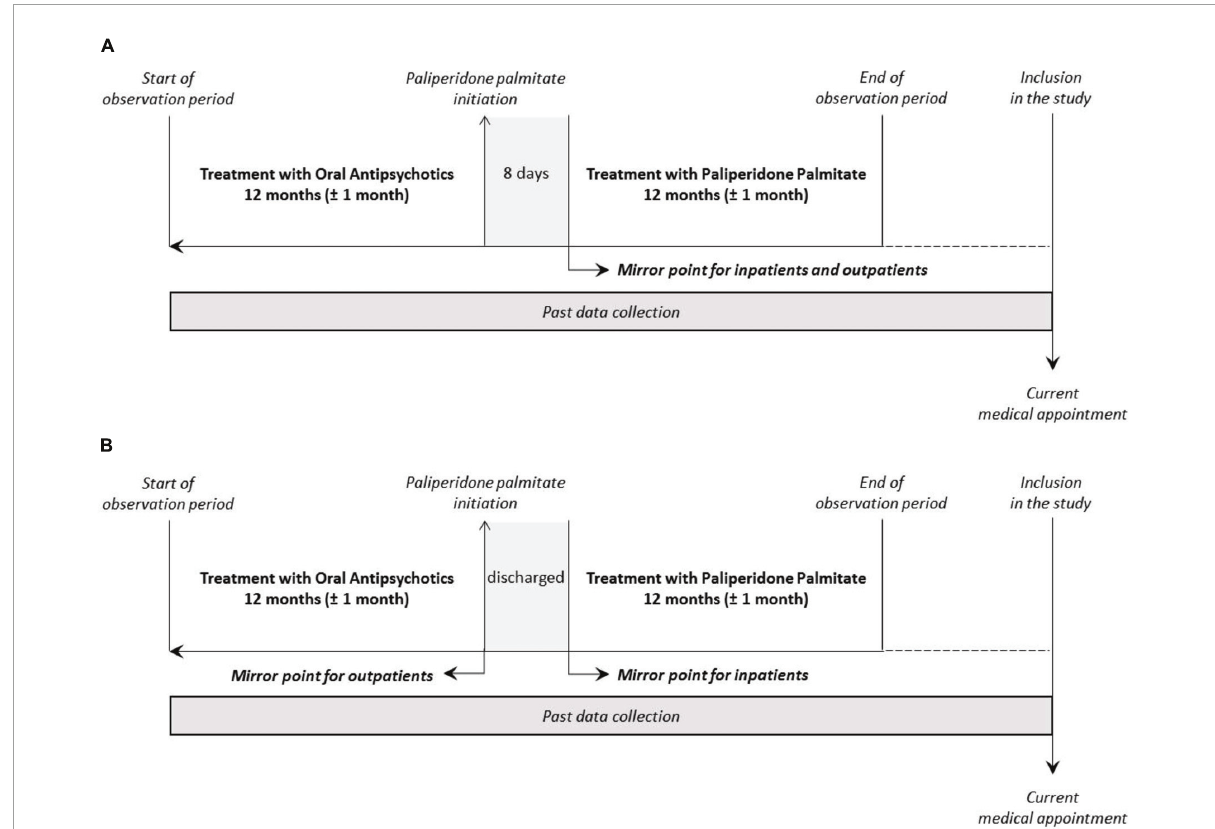
FIGURE1 Study design: main (A) and sensitivity (B) analyses. (A) Main analysis: the mirror point of the study was set at 8 days after treatment initiation for patients that started PP1M in the community (outpatients) and for those that started PP1M during a hospitalization (inpatients); (B) sensitivity analysis: schematic representation of the sensitivity analysis that considers the mirror point for outpatients as the date of PP1M initiation, and for the inpatients as the date of the hospitalization